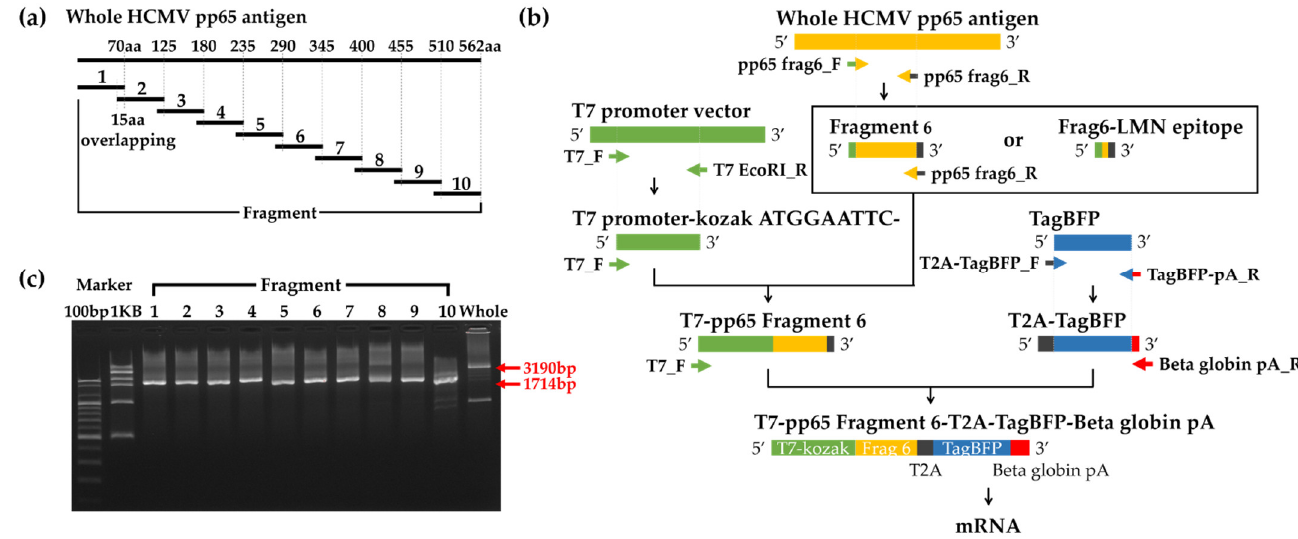
Figure 1. Generation of mRNA including pp65 whole and fragment antigens by TAP. ( a ) Ten fragments of the pp65 antigen consist of 70aa and are overlapped by 15aa. ( b ) Schematic summary of TAP process. Fragment 6 and the LMN epitope are exemplified. Finally, the T7 promoter-Kozak-pp65 whole or fragment or predicted epitope-T2A-BFP-beta-globin pA was amplified by TAP. mRNA for electroporation was produced by IVT of TAP products. ( c ) 2% Agarose gel electrophoresis of DNA amplified by TAP. The band size of the whole and fragment TAP products are 3190bp and 1714bp,